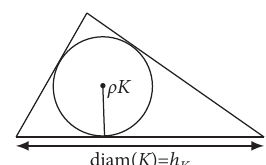
Figure 2: Isotropic element K in R 2